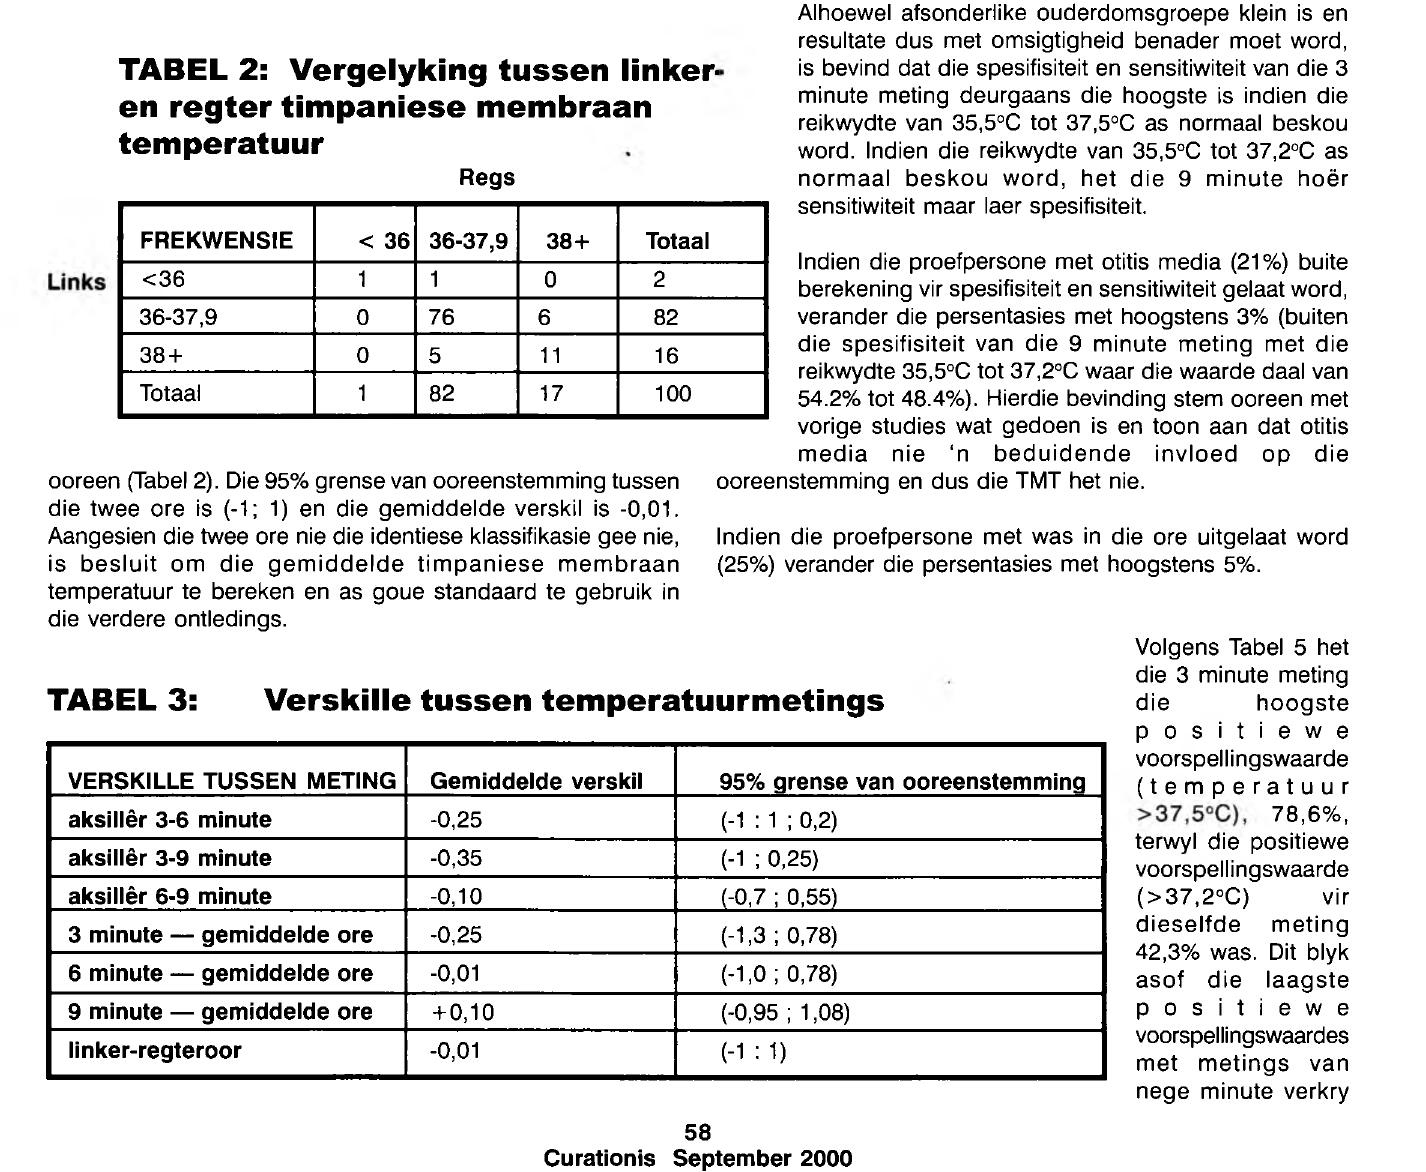
TABEL 2: Vergelyking tussen linker- en regter timpaniese membraan temperatuur